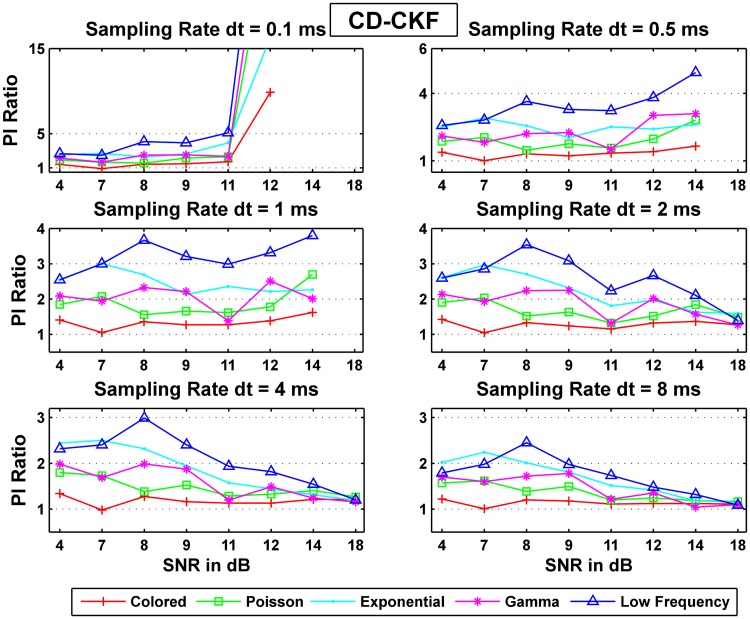
Probability ratios PInoise/PIwhite for CD-CKF for different sampling intervals and noise structures.